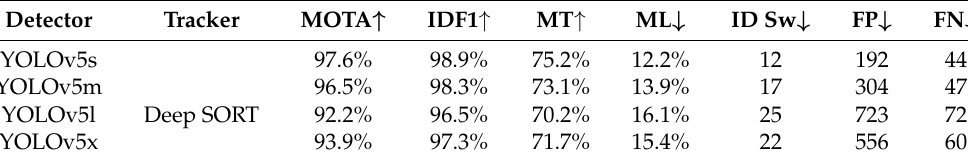
Table 2. The multiobject tracking results. ↑ indicates that higher scores are better, and ↓ means the opposite.